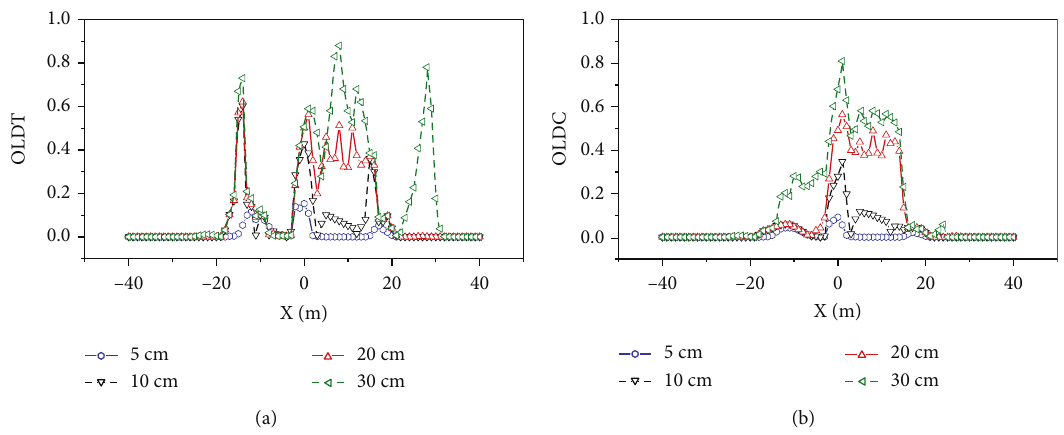
Figure 10: Overall lining damage under di ff erent fault displacements. (a) OLDT. (b) OLDC.